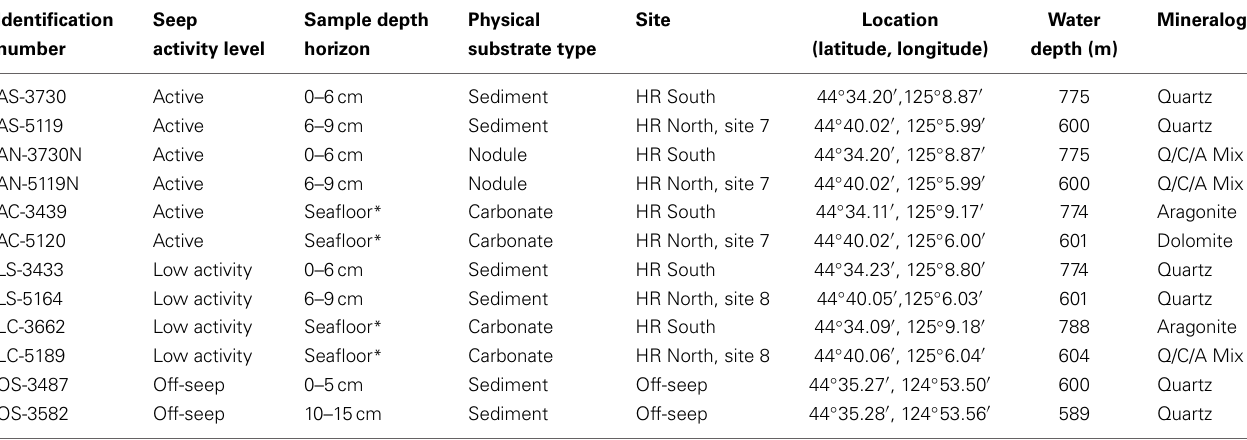
Table 1 | Identification numbers, site location details, and mineralogical identifications of carbonate, sediment, and nodule samples used in this study from the Oregon margin,